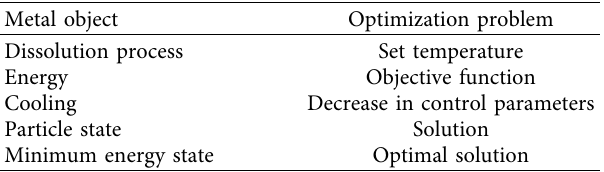
Table 1: Comparison between metal object and optimization problem.